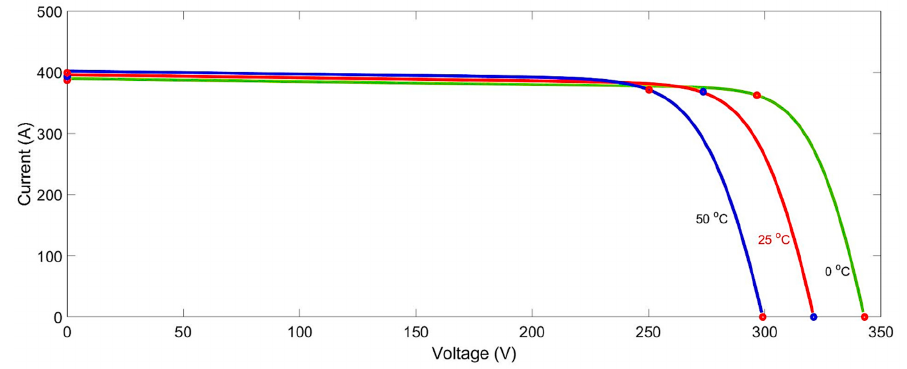
Figure 4. The photovoltaic voltage and current curves.